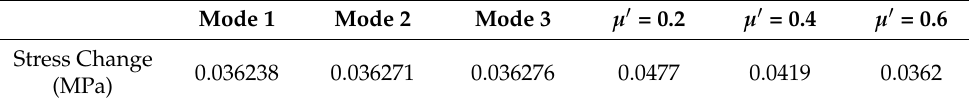
Table 6. Stress changes according to different models and different friction